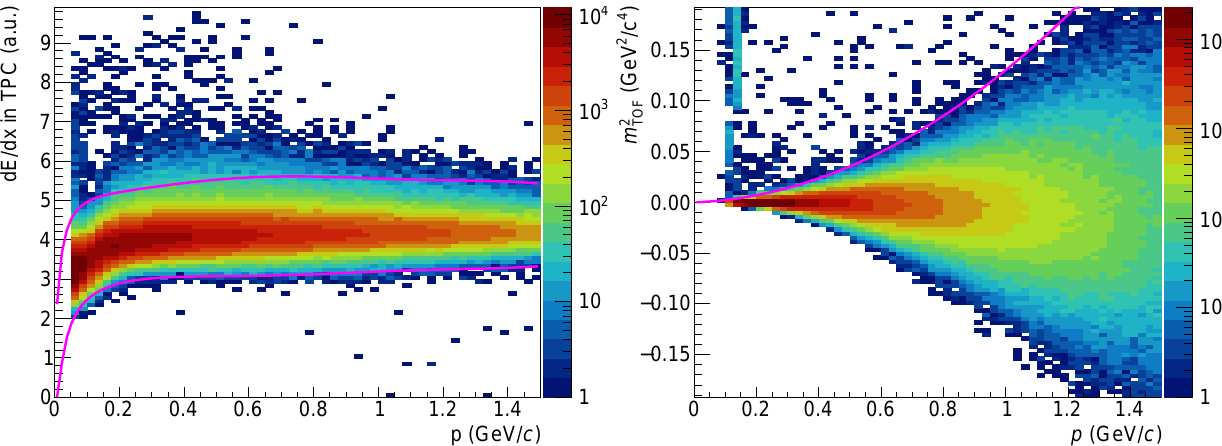
Figure 2. ( Left ) Distribution of energy losses in the time projection chamber (TPC) for electrons as a function of momentum. ( Right ) Distribution of reconstructed squared mass in the time-of-flight (TOF) for electrons as a function of momentum. Selection limits are shown with magenta